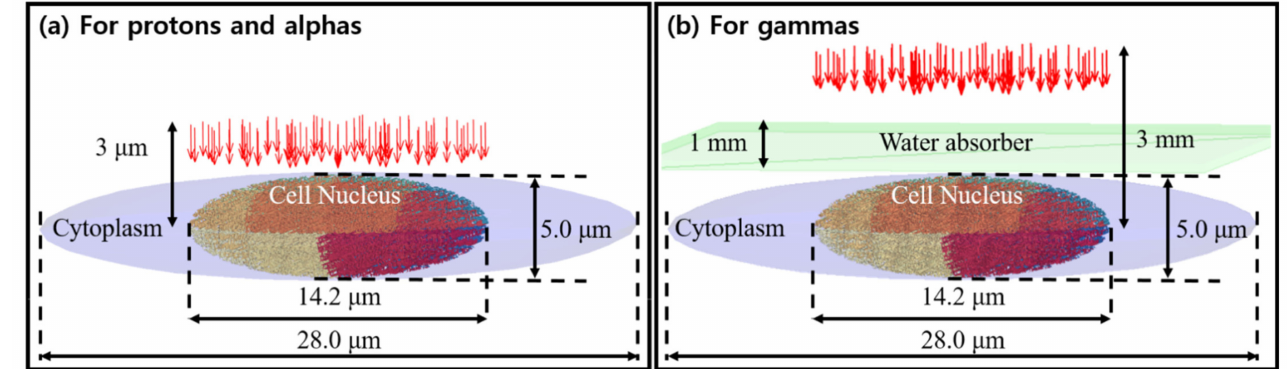
Figure 2. A schematic illustration of the geometrical configuration of the human cell nucleus and source term. Figures adapted from